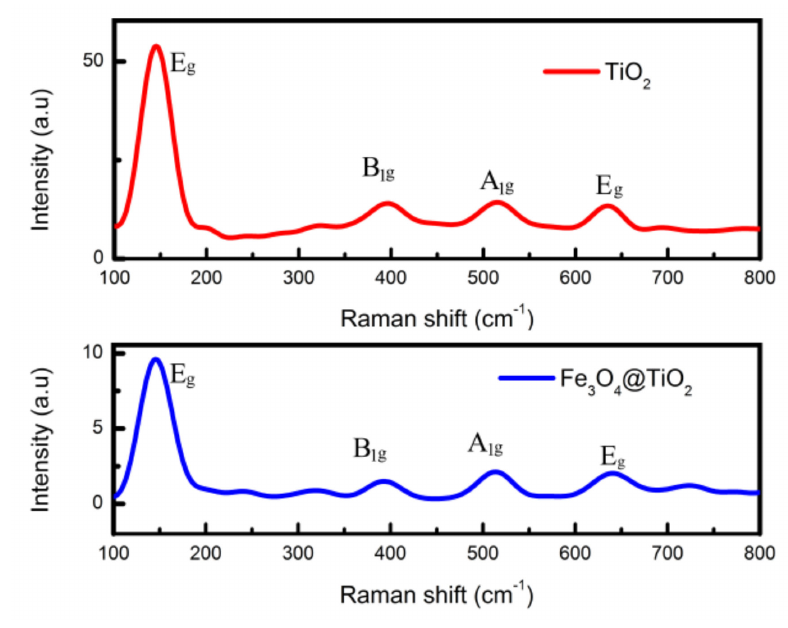
Figure 2. Raman spectra in the range of 100–800 cm − 1 for TiO 2 and Fe 3 O 4 @TiO 2 . The morphologies of Fe 3 O 4 , TiO 2 and Fe 3 O 4 @TiO 2 are shown in Figure 3. The par- ticle diameters of Fe 3 O 4 , TiO 2 and Fe 3 O 4 @TiO 2 are about 390 nm, 100 nm and 120 nm, respectively. The size of Fe 3 O 4 @TiO 2 and TiO 2 particles is uniform, but there is particle agglomeration. The possible reason is that the spherical structure is corroded by acid during the compounding process. Combined with the results of FESEM and XRD, it is found that the particle size inferred from FESEM is larger than that obtained by XRD. It is suggested that the shape of larger particles is determined by the agglomeration of adjacent smaller crystallites [21]. EDS patterns and FESEM elemental mapping of Fe 3 O 4 @TiO 2 are shown in Figure 4. The results indicate that Ti and Fe elements are evenly distributed, which firmly confirms the incorporation of TiO 2 and Fe 3 O 4 in the composite.